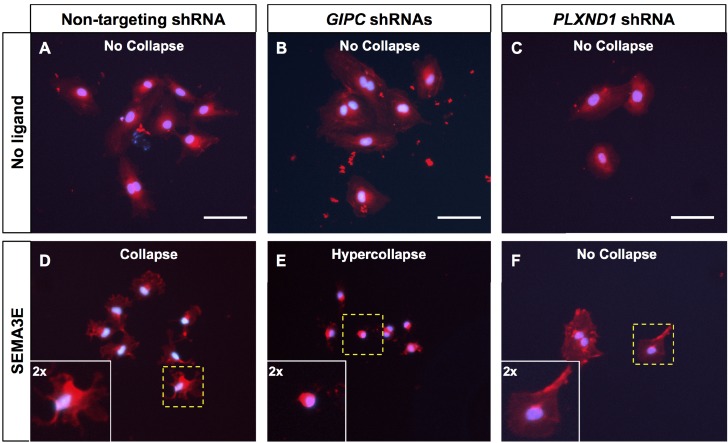
GIPC knockdowns potentiate the SEMA3E-induced/PLXND1-dependent cell collapse of primary HUVEC.(A–F). Representative fluorescent images of HUVEC morphology in cell collapse experiments under the following conditions. No ligand (A–C; top) or 45 min stimulation with 10 nM of SEMA3E (D–F; bottom). In each picture, the square area marked by yellow dotted sides is shown at twice the magnification at the bottom left corner and delimited by white sides. shRNA treatments as follows. Non-targeting, control (A, D), GIPC (GIPC1, GIPC2, and GIPC3; B, E), and PLXND1 (C, F). Scale bars (white horizontal lines), 100 μm. (A–C) Without ligand stimulation cells are uncollapsed regardless of the knockdown condition. (D, E) Cell collapse under ligand stimulation. Cells treated with non-targeting, control shRNA collapse (D). GIPC knockdown cells hypercollapse (E). SEMA3E-induced collapse is PLXND1-dependent. PLXND1 knockdown abrogates the morphological response (F). Cell collapse data collected from three independent experiments. This figure is related to Figure 7—figure supplement 4.